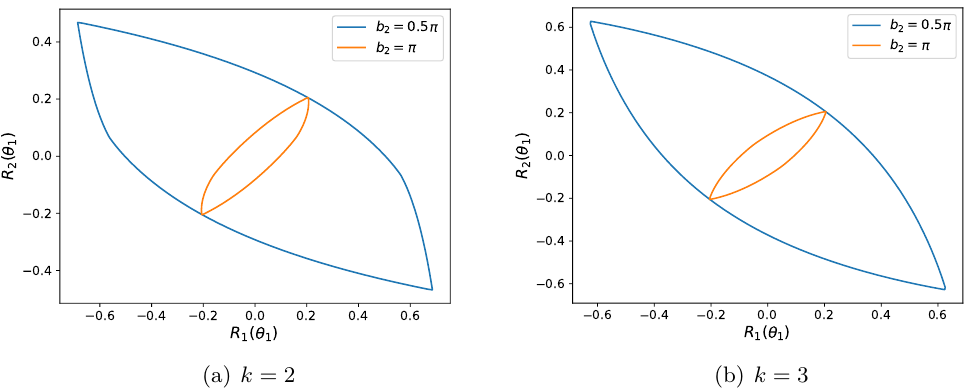
Figure 6 . Plot of the ( R 1 ( θ 1 ) , R 2 ( θ 1 )) allowed region for the NLSM and θ 1 = 0 . 9879 i . We consider the case N = 6 , and k = 2 , 3 and analyticity regions b